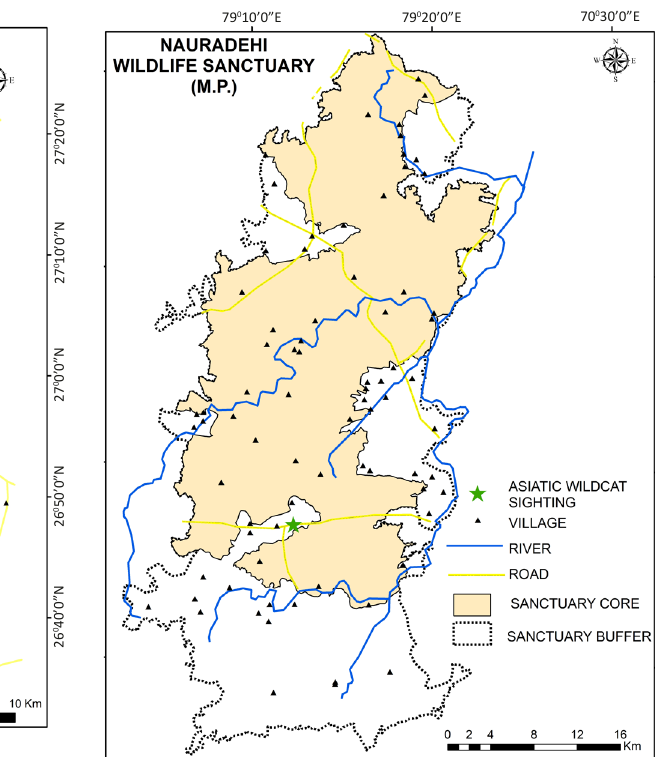
Figure 2c. Sighting location in Nauradehi Wildlife